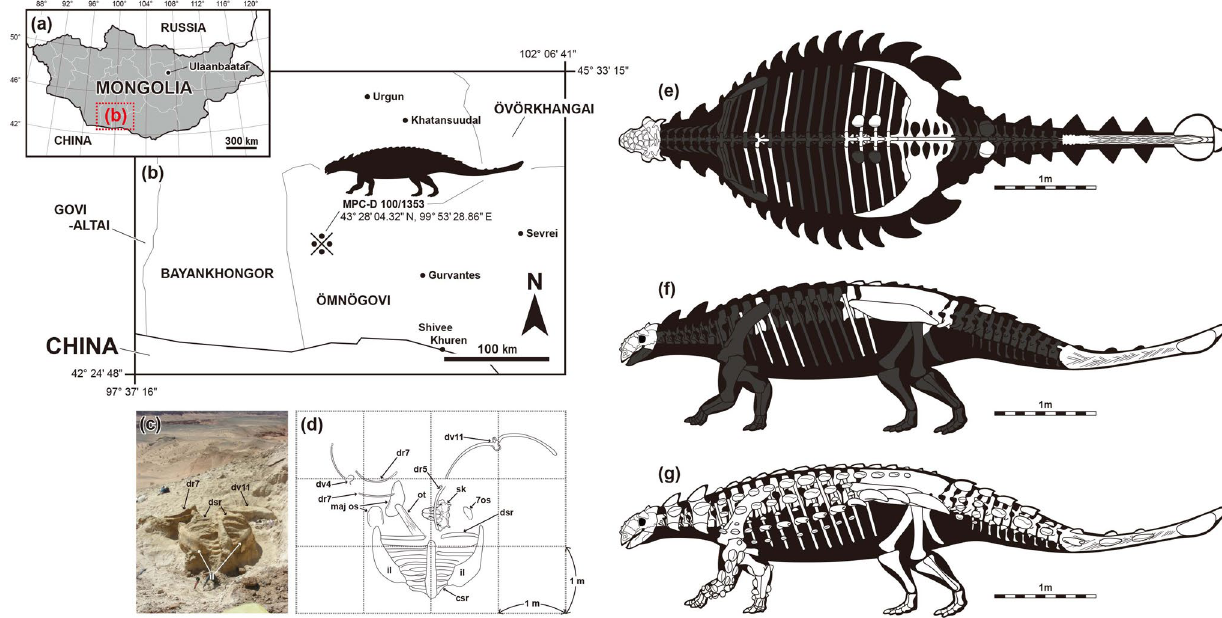
Figure 1. Map showing the locality where Tarchia tumanovae sp. nov. (MPC-D 100/1353) was discovered ( a–d ). ( a ) Map of Mongolia. ( b ) Enlarged map of the dotted lined rectangle of A marked with the fossil locality ( ※ ). ( c ) Photo of the excavation site. ( d ) Quarry map showing bone location. ( e–f ) Skeletal diagram of the specimen in dorsal ( e ) and left lateral ( f ) views (white bones represent recovered elements). ( g ) Skeletal reconstruction with dermal armour. Abbreviations: 7os, Type 7 osteoderm; csr, caudosacral vertebra; dr,